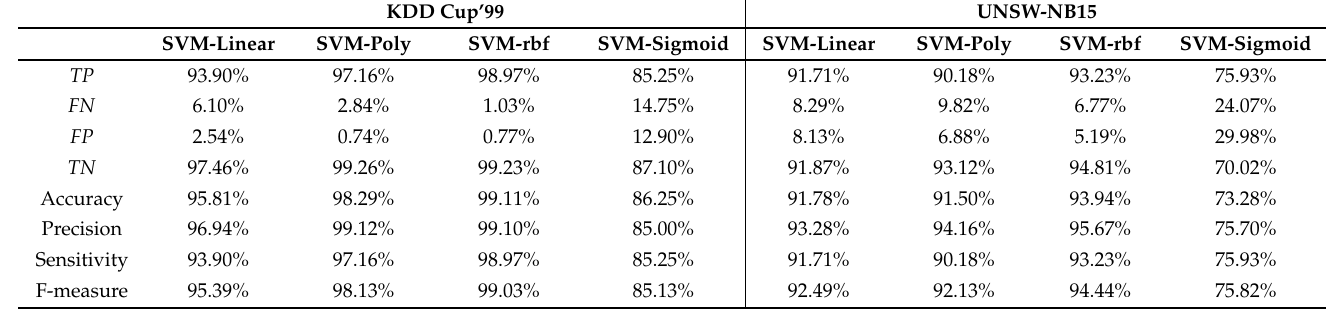
Table 6. The obtained results.